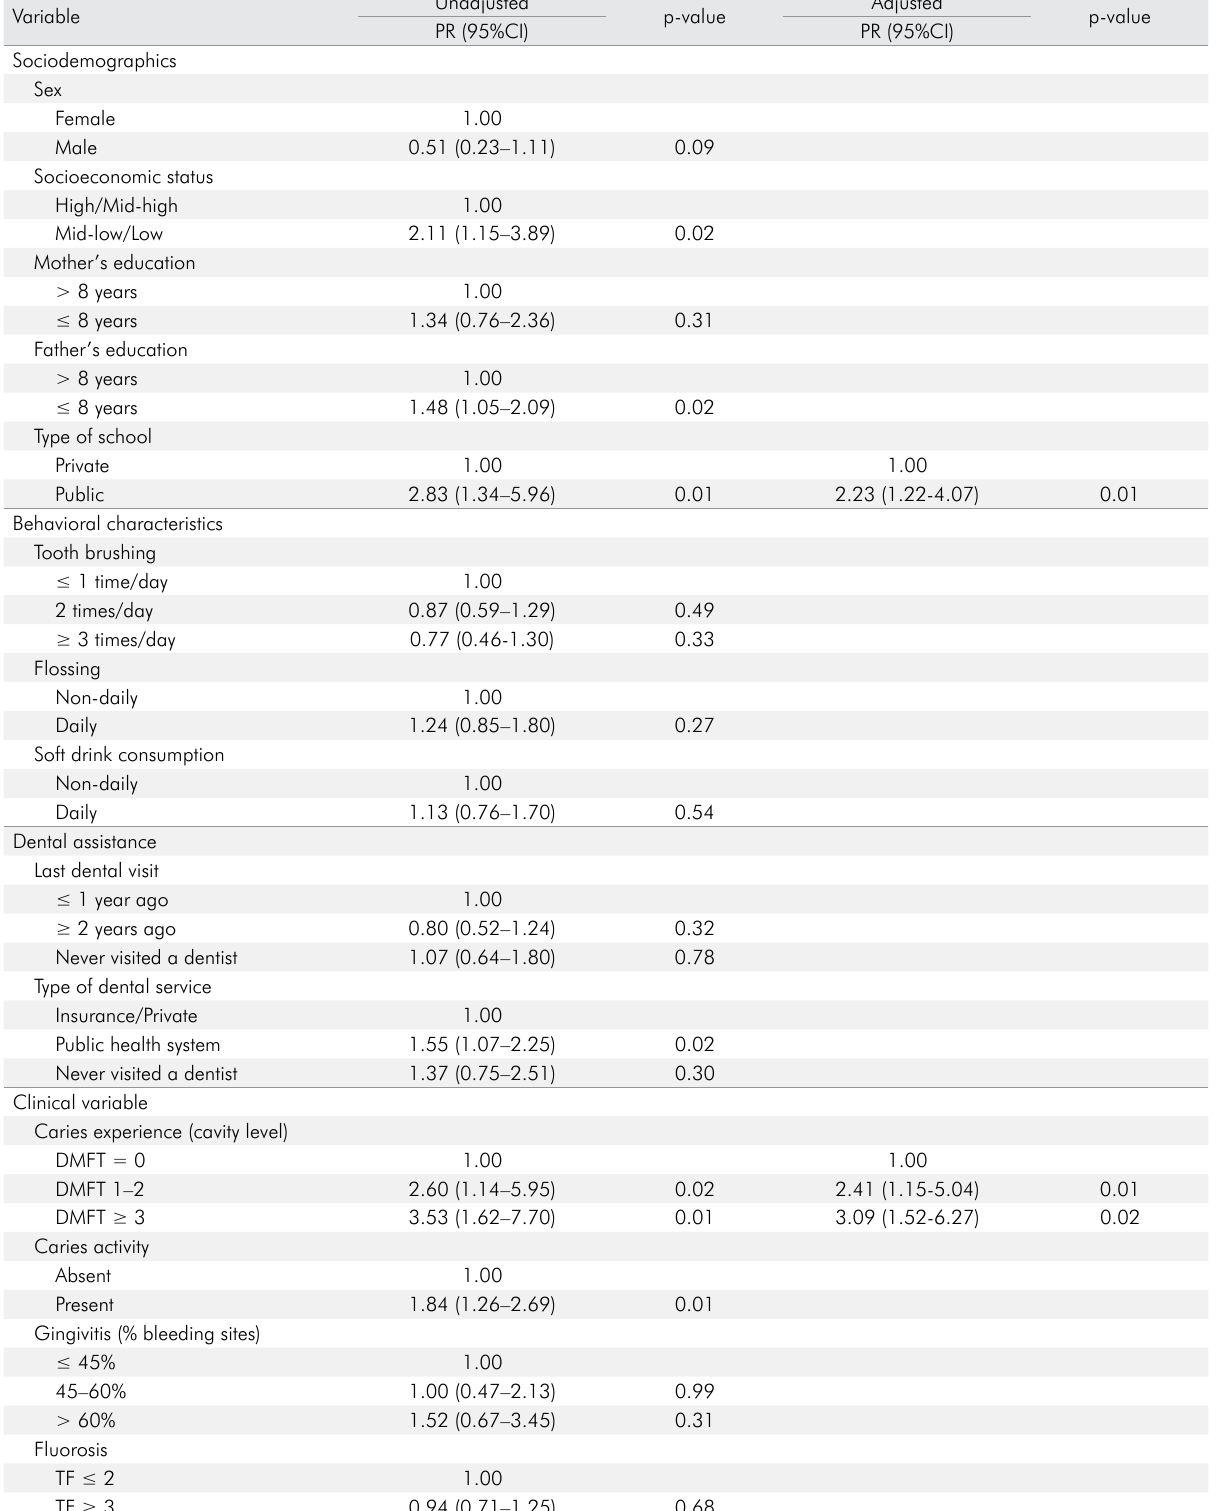
Table 2. Association between predictor variables and the prevalence of underlying dentin shadows. Unadjusted and adjusted Poisson regression models (n =